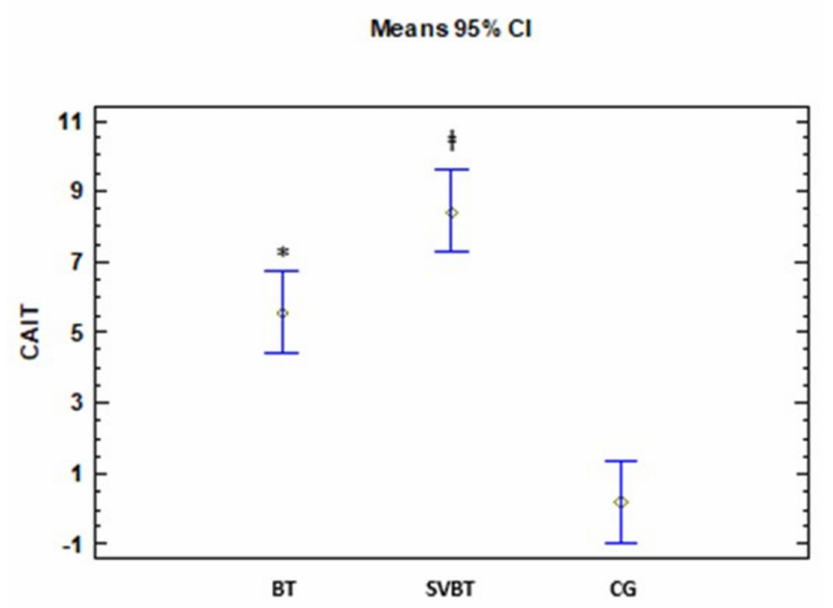
Figure 2. CAIT change scores after the intervention. Cumberland ankle instability tool (CAIT). ‡ (SVBT > BT); * (BT >